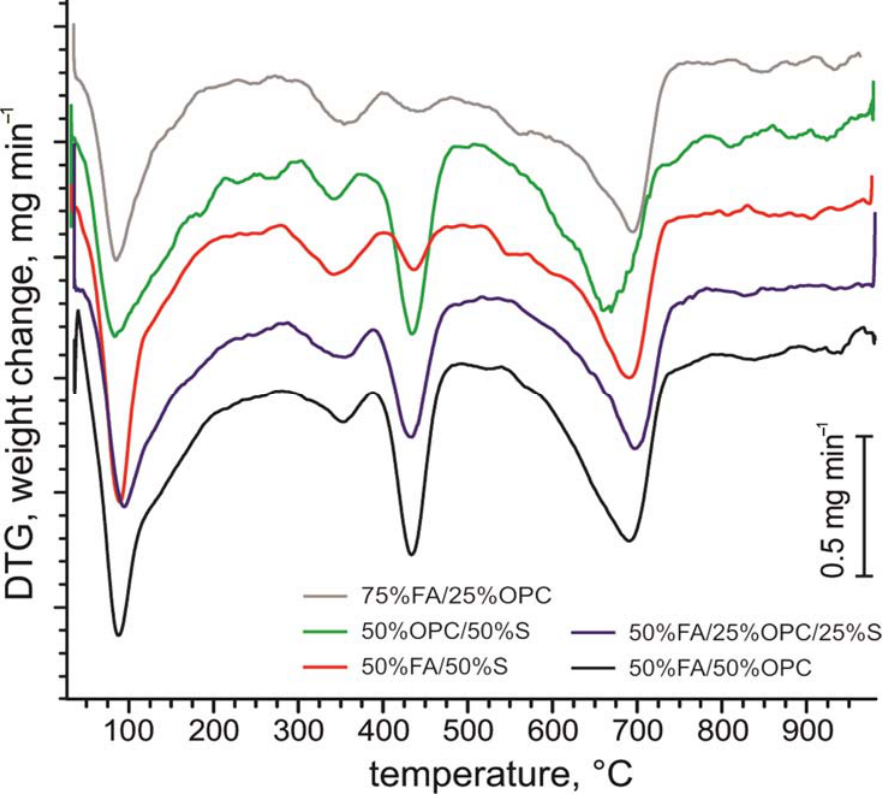
Figure 3. Representative curves of thermogravimetric (DTG) analysis of studied FA ‐ CSA and OPC pastes after 28 days of curing. pastes after 28 days of